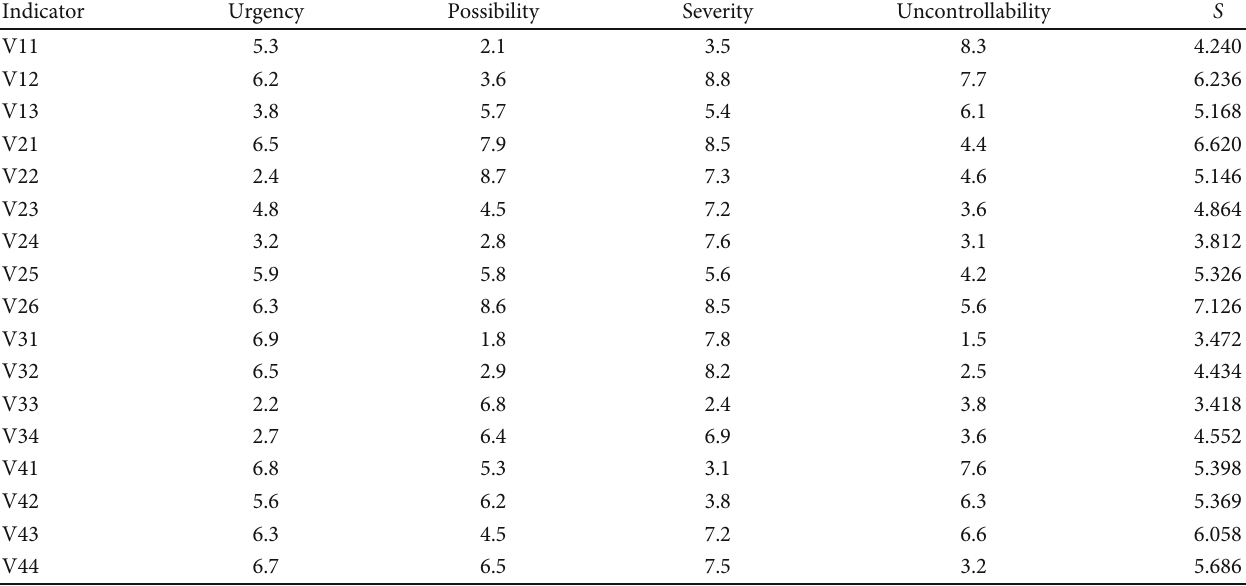
Table 6: Indicator evaluation status values under di ff erent risk